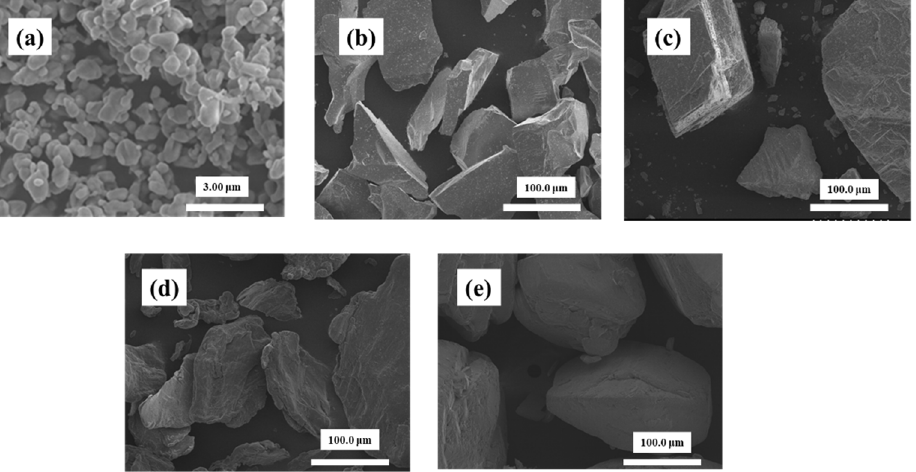
Figure 2. SEM images of particles. The particles used in this study were: β -TCP particles ( a ), white alumina particles ( b ), calcium carbonate particles ( c ), agar particles ( d ), and glycine particles ( e ).